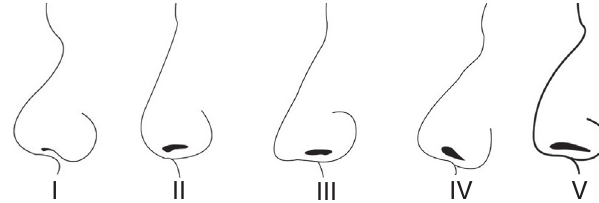
Nasal profiles in young Turkish